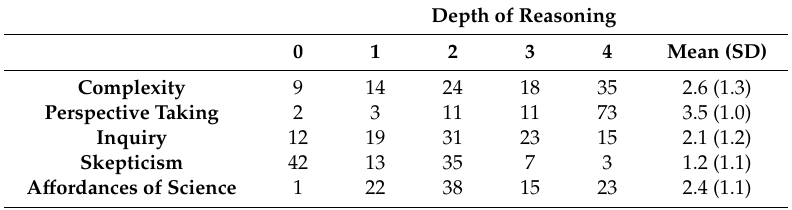
Table 3. Percentage of responses scoring at each level and the mean score for dimensions of